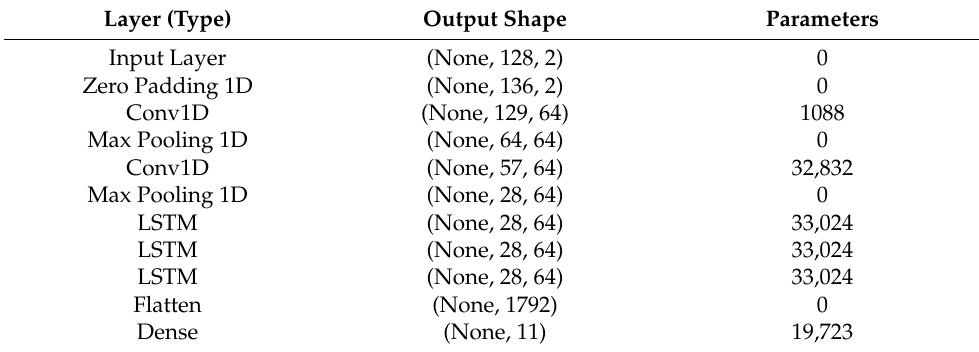
Table 6. Architecture of CNN 1D +